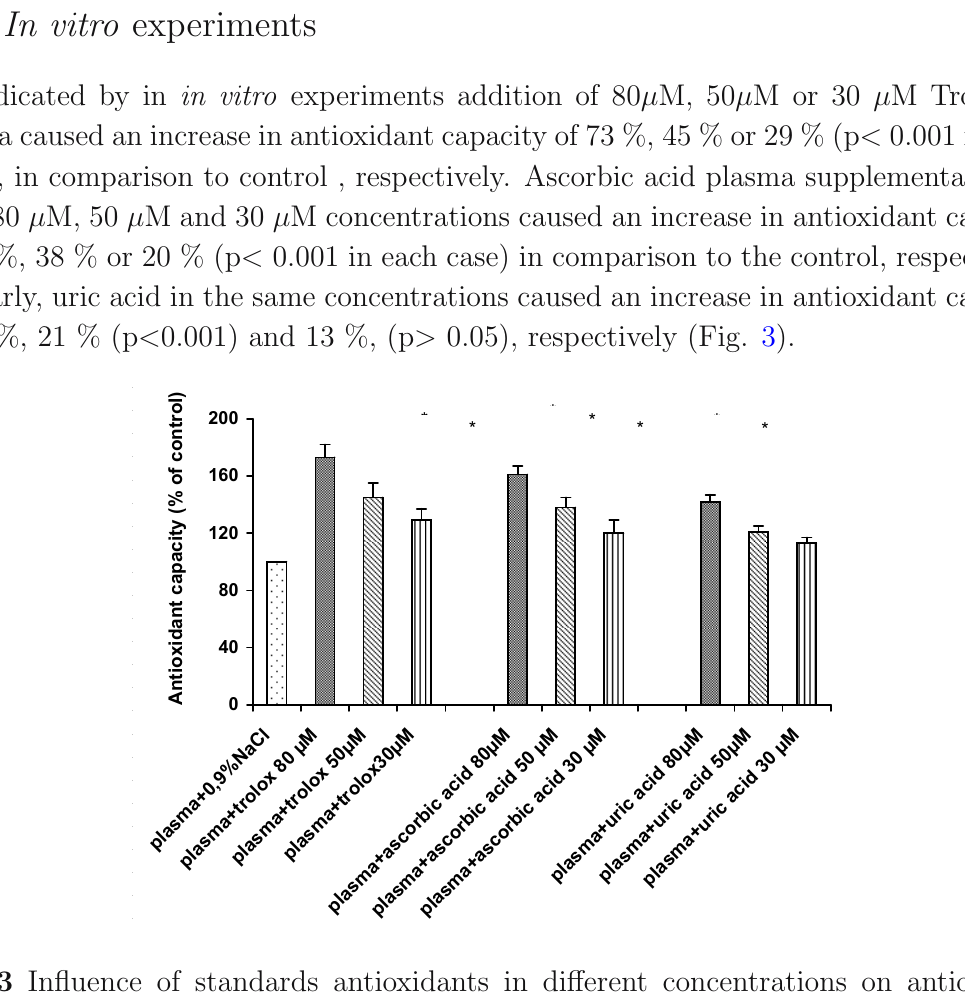
Fig. 3 Influence of standards antioxidants in different concentrations on antioxidant capacity of plasma (mean ± SE; asterisk represents P < 0.001 vs. plasma +